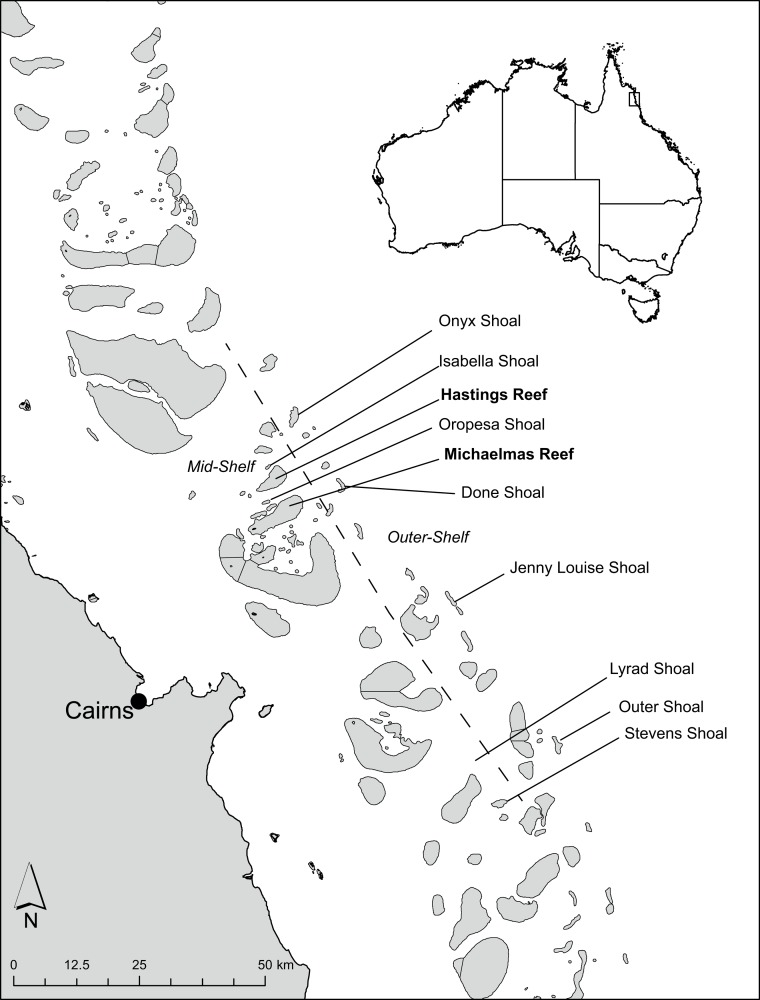
Map showing the location of study sites in the central Great Barrier Reef.Dashed line shows the boundary between mid-shelf and outer-shelf reefs. Emergent reef names are highlighted in bold typeface.